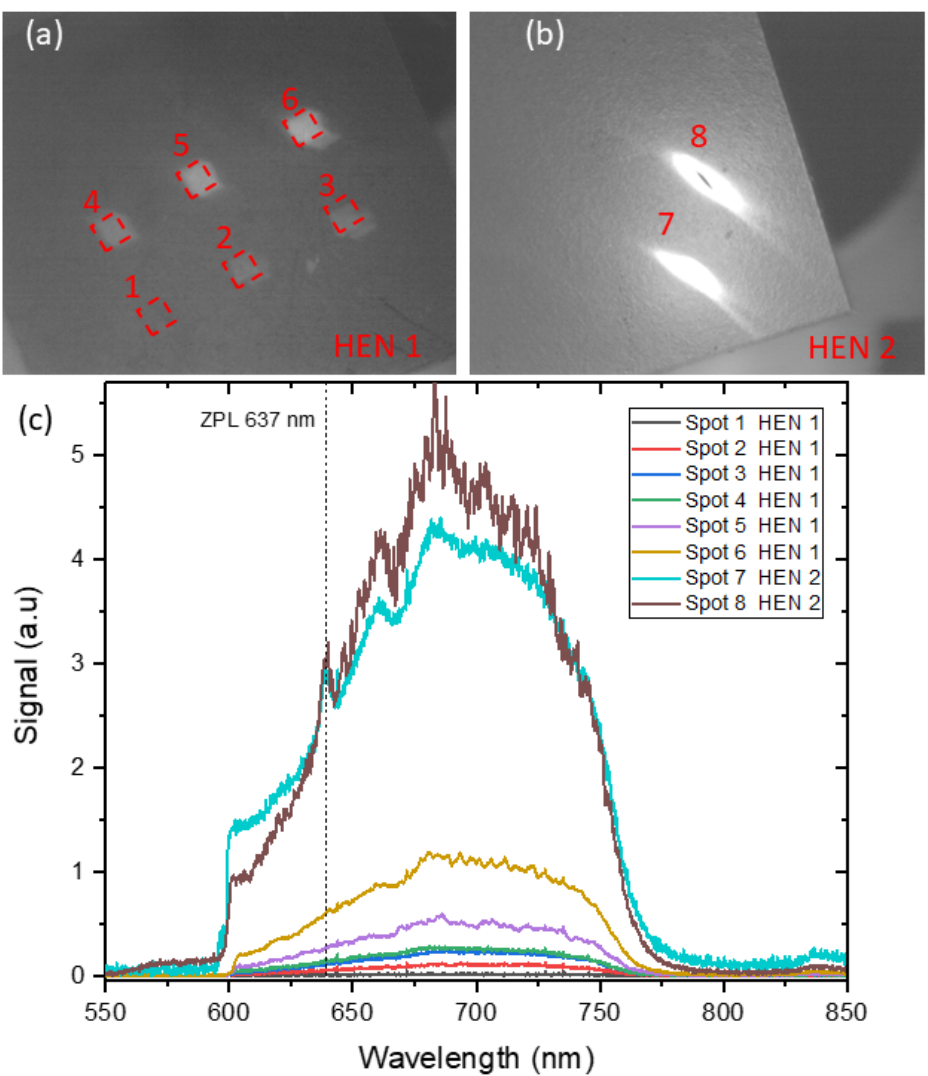
Figure 1. The proton-irradiated samples: ( a ) the sample HEN1 with six areas of the implanted doses in the range of 1.5 × 10 13 to 1.5 × 10 16 ions/cm 2 ; ( b ) the sample HEN2 with two areas of the implanted dose range of 4.5 × 10 16 to 1.5 × 10 17 ions/cm 2 ; ( c ) the fluorescence spectra from the marked individual spots. The zero-phonon line (ZPL) is marked with a dotted